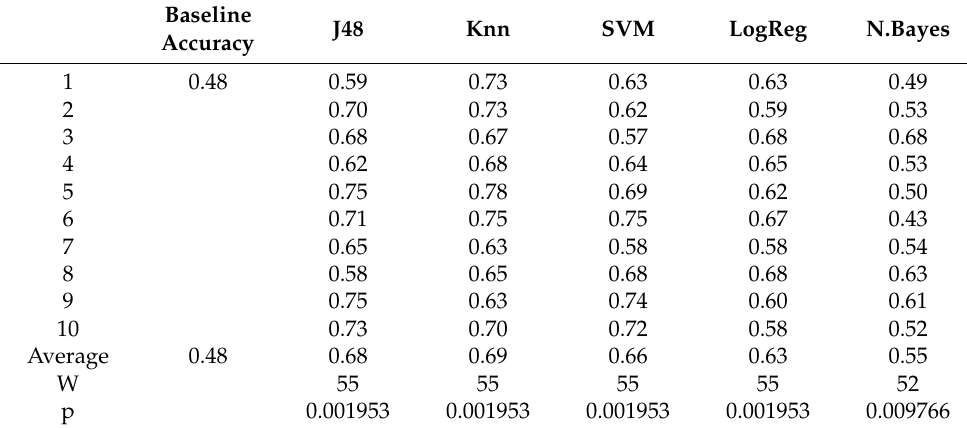
Table 9. Results of the Wilcox signed-rank test of 10-folds’ cross validation for comparison of used classification algorithms with baseline classification in the majority class.